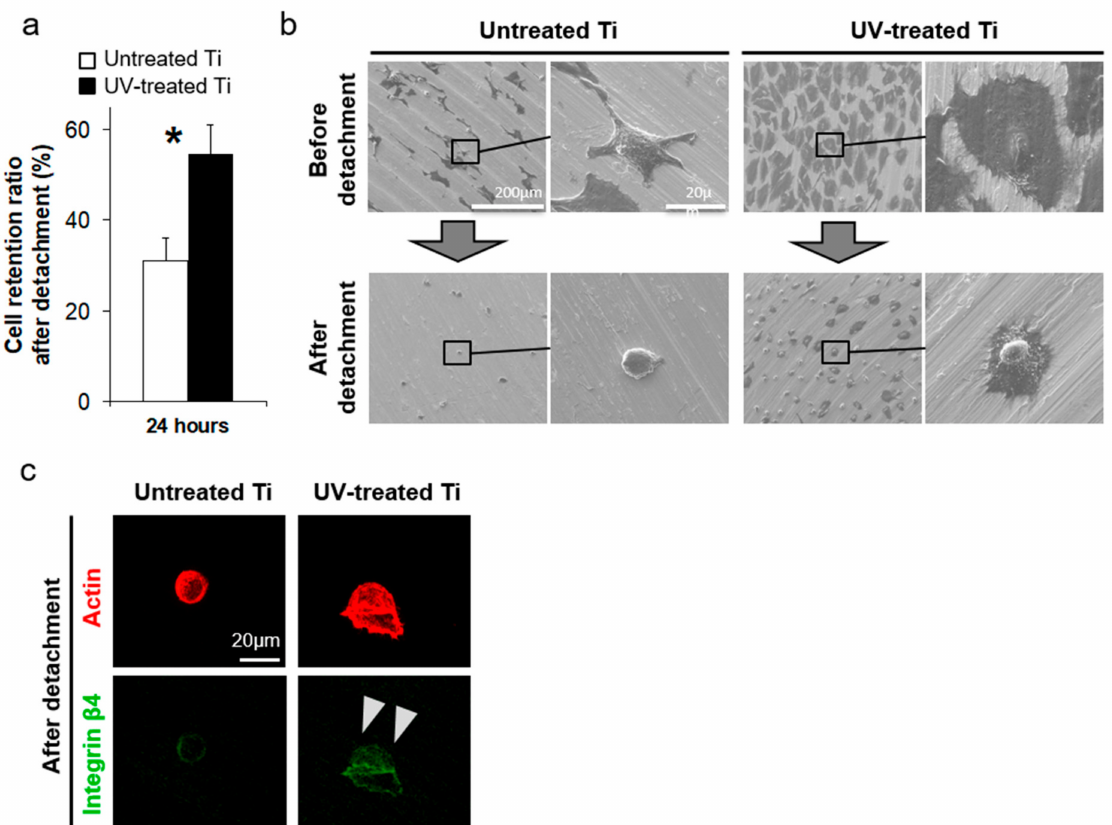
Figure 6. Cell detachment assay for the evaluation of cellular retention force to a titanium surface. After 24 h of culture, cells were chemically and physically detached by agitation in 0.025% Trypsin solution. ( a ) The cell retention ratio was calculated by quantifying the number of cells attached to the titanium surfaces before and after attachment (* p < 0.05). Cell retention ratio (%) = (the number of cells attached to the titanium surfaces before detachment)/(the number of cells attached to the titanium surfaces after detachment) × 100. ( b ) Representative scanning electron microscope images of cells before and after detachment on the untreated control and UV-treated titanium surfaces. ( c ) Integrin β 4 expression in the cells after detachment (white arrowhead). Scale bar = 20 µ